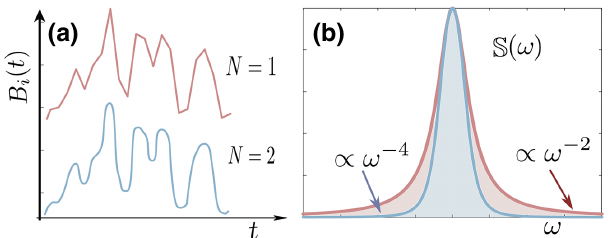
FIG. 2. Schematic comparison between a Markovian noise for N = 1 and a non-Markovian noise with N = 2 for one- dimensional, local-in-time stationary noise processes with dif- ferent constraints on the differential operator D . (a) Examples of single realizations of field fluctuations B i ( t ) for both cases. The differential operator has constraints up to the first derivative for N = 1, where the field fluctuation is continuous but not differ- entiable. For N = 2, the field fluctuation and its derivative are continuous. (b) The corresponding noise spectrums S (ω) . For N = 1, the spectral density is a Lorentzian and, for N = 2, the inverse of a quartic polynomial, with power-law tails ∝ ω − 2 and ∝ ω − 4 for large frequencies,